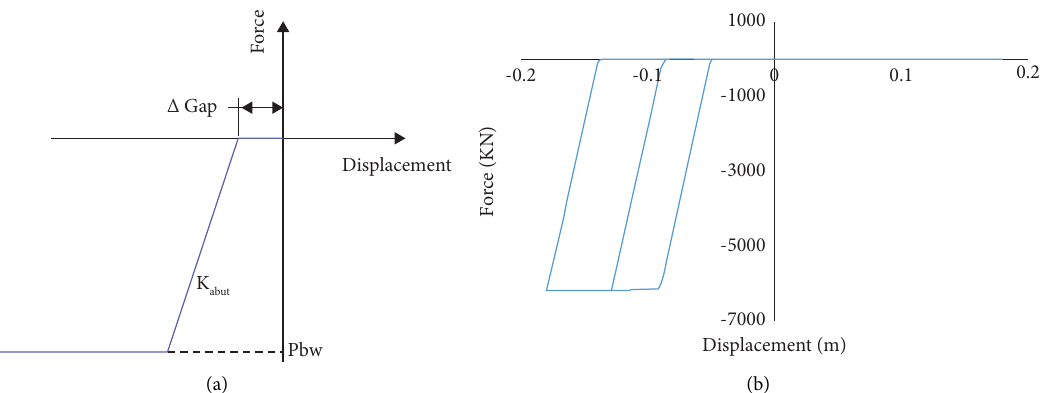
Figure 6: Numerical model of the bridge.